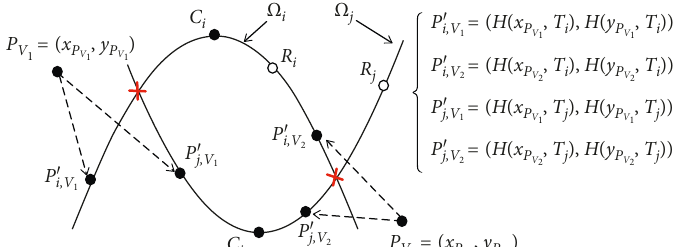
Figure 5: Diagrammatical representation of password point and challenge and response points for different timestamps in the extended P- GMGP when M � 2.